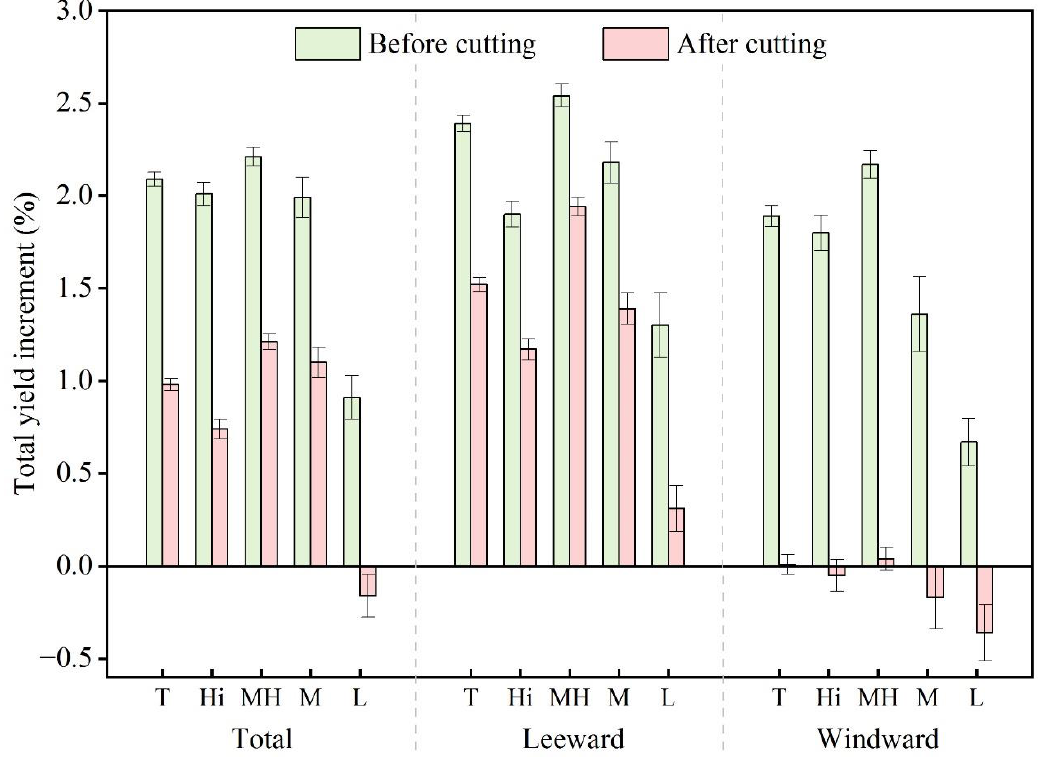
Figure 5. Yield increment of shelterbelt with different densities before and after shelterbelt cutting. The total, leeward, and windward labels represent the all, leeward, and windward target shelterbelt groups, respectively. The x -axis represents the shelterbelt classification (T: all densities, Hi: high density, MH: medium – high density, M: medium density, L: low density).